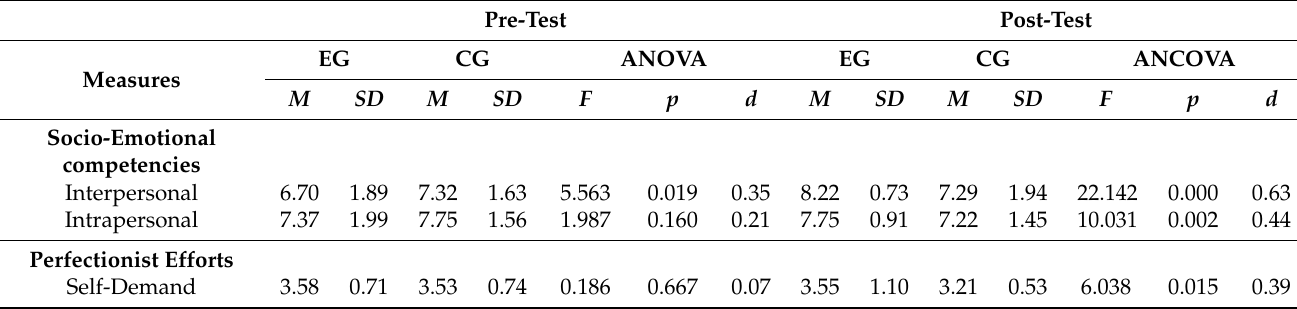
Table 2. Mean, standard deviation, variance analysis (ANOVA), covariance analysis (ANCOVA), and effect size for differences in means (Cohen’s d ) in experimental and control groups. Pre-Test Post-Test